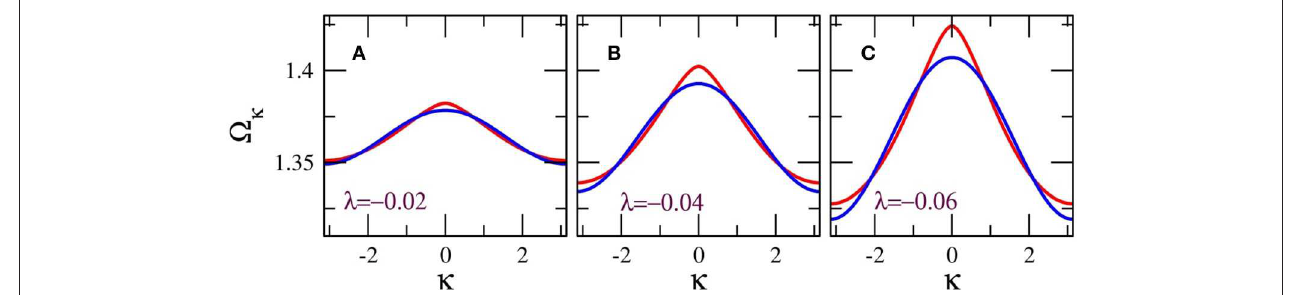
(cid:127) κ for non-local (red) and local (blue) coupling, for β L =